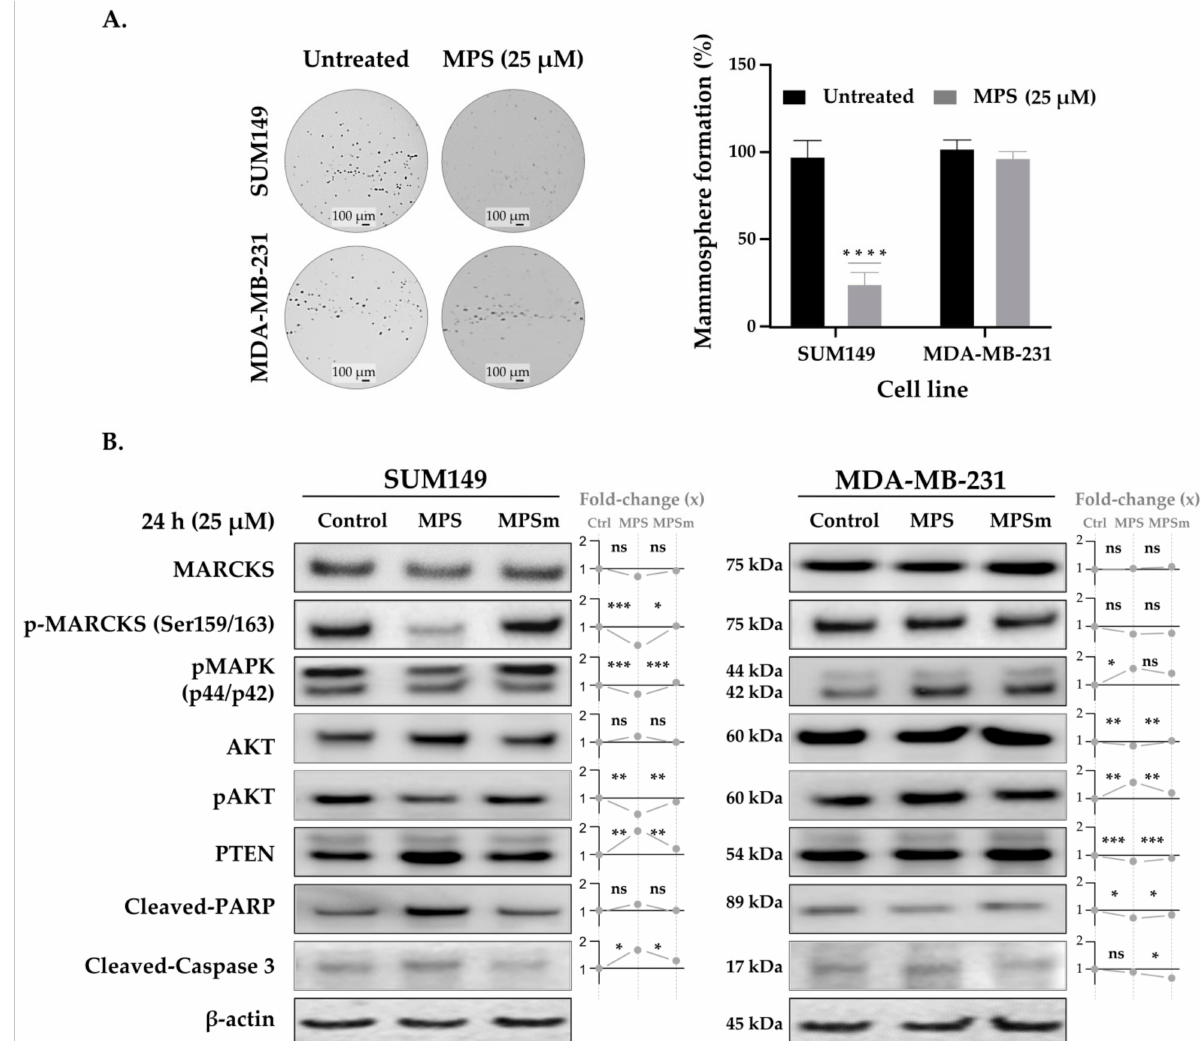
Figure 2. MARCKS promotes mammosphere formation of IBC cells compared to nIBC and Western blot analysis. ( A ) Representative images (left) showing that MARCKS inhibition using MPS peptide impaired mammosphere formation in SUM149 compared to MDA-MB-231 cells (magnification × 10); box plots are shown (right). ( B ) Western blot analysis. SUM149 and MDA-MB-231 cells were treated with 25 µ M MPS and MPSm, and after 24h of incubation, the protein was extracted, and the expression was analyzed using Western blot. The results were quantified and normalized using the protein expression level of β -actin. The phosphorylated forms were normalized to the respective total protein when available (MARCKS and AKT). To the right of each blot, the fold-change of each treatment (MPS and MPSm) is relative to the untreated condition (control). The adjusted p -value using Bonferroni (indicated with “ns” or stars) is for the t -test comparing expression in between MPS and control conditions and between MPS and MPSmconditions. In SUM149, we found a decrease of pMARCKS protein expression in MPS-treated cells compared to untreated and MPSm-treated cells, inducing then a decrease of pAKT and an increase of PTEN expressions and an increase of apoptotic markers expression (cleaved-PARP and cleaved-Cas3), and a decrease of pMAPK expression explaining in part the inhibition of primary mammosphere formation in IBC cells. By contrast, no similar change in expression was observed in MD-MB-231 cells. Data were represented as mean ± SD. **** p ≤ 0.0001, *** p ≤ 0.001, ** p ≤ 0.01, * p ≤ 0.05, ns: p > 0.05, (3